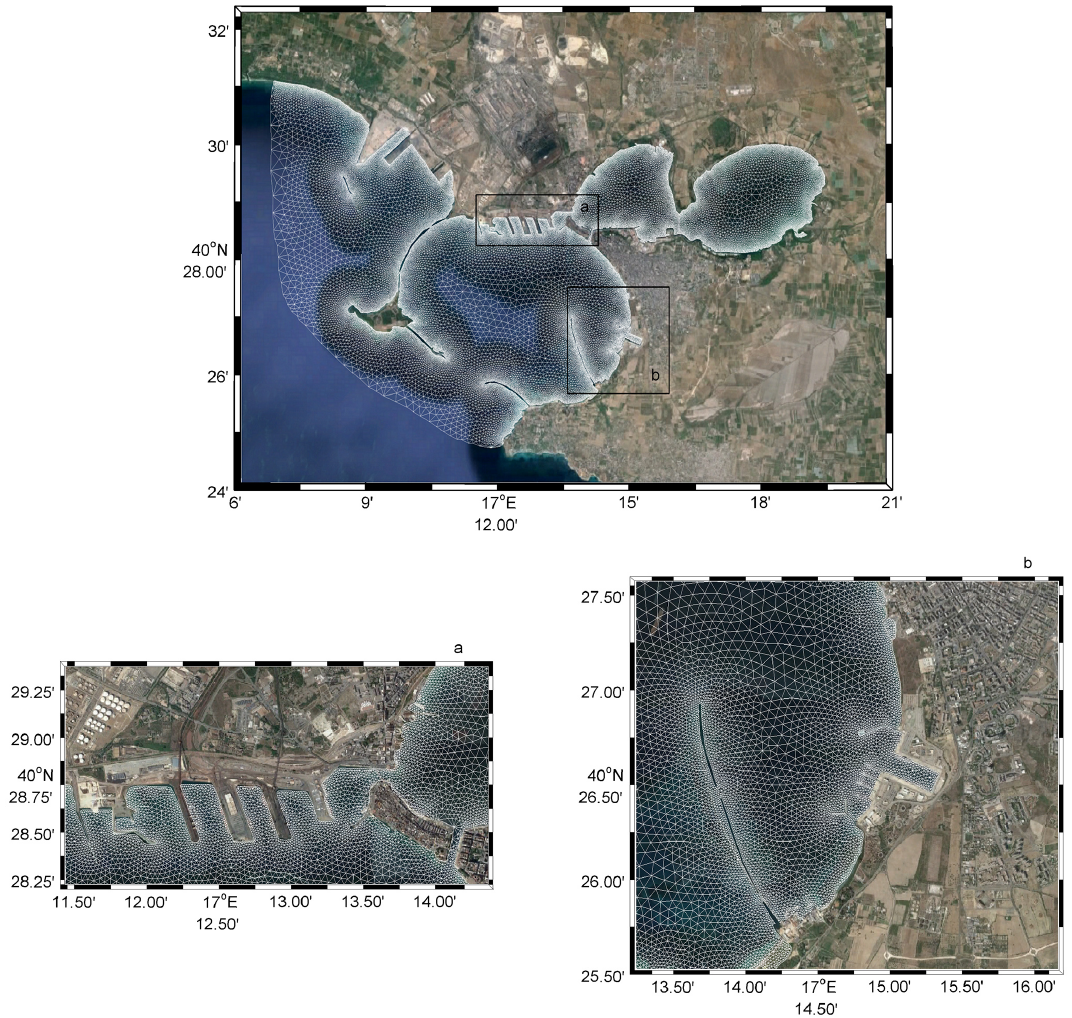
Figure 3. 3-D model of the Taranto Sea: the overall grid (top panel) and two detailed zones (bottom panels) close to the commercial harbor (a) and the military harbor (b) of Taranto; background images are from Google Earth, 2016, privately processed.